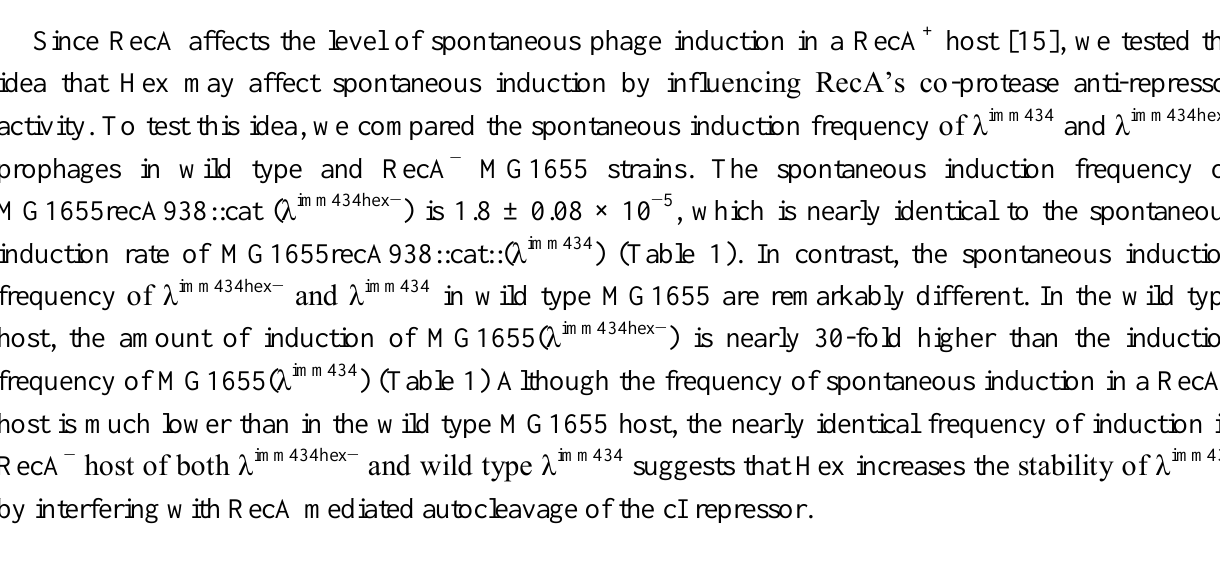
Table 1. Effect of hex Deletion on Spontaneous Induction of RecA − MG1655(λ imm434 ) Lysogens. The values (+/− standard deviation) were determined as described in the Experimental Section. Data is an average based on twenty four separate